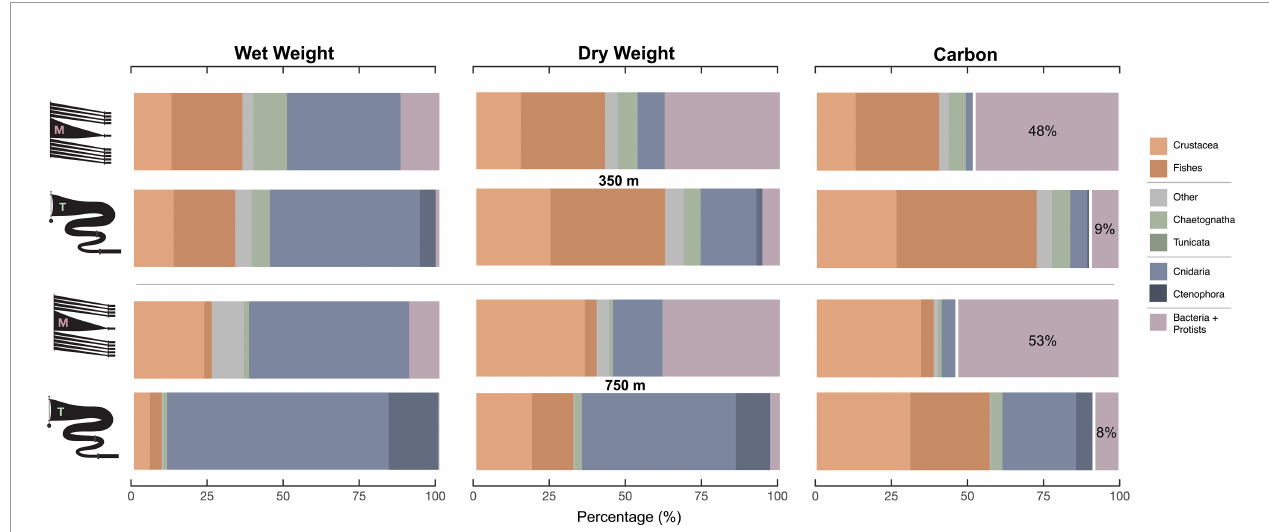
FIGURE 3 | Percentage wet weight, dry weight, and carbon for zooplankton broad taxonomic groups and microbes in Monterey Bay identi fi ed in MOCNESS and Tucker trawls at 350 (top) and 750 m (bottom). Bars that represent the relative carbon contributions of bacteria and protists are isolated and their values are shown to highlight the differences between trawl